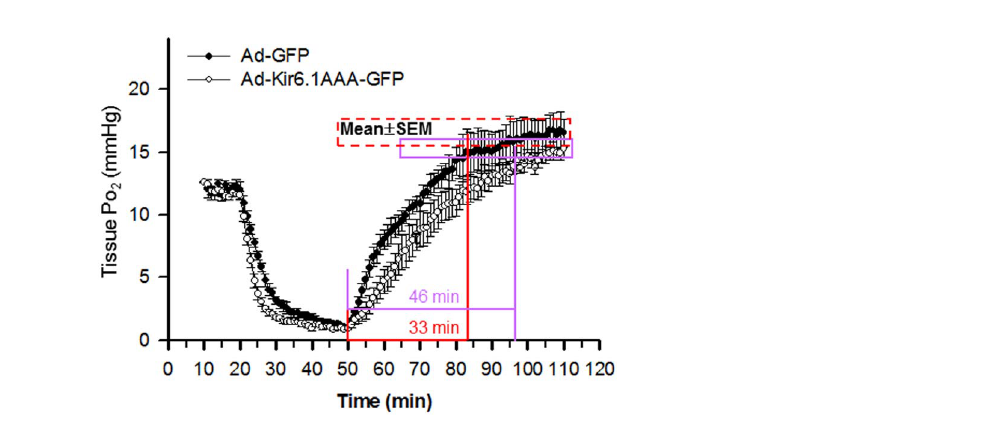
Figure 6. Myocardial tissue oxygenation during ischemia and reperfusion in Kir6.1AAA-transfected mouse hearts. In vivo EPR oximetry was performed to measure tissue Po 2 in the Ad-GFP and Ad- Kir6.1AAA-GFP transfected hearts before (0–20 min), during (20–50 min), and after (50–110 min) 30 min ischemia and 60 min reperfusion (N 5 5/group). As shown, Kir6.1 AAA gene transfer markedly prolonged myocardial tissue oxygenation recovery time t from 33 to 46